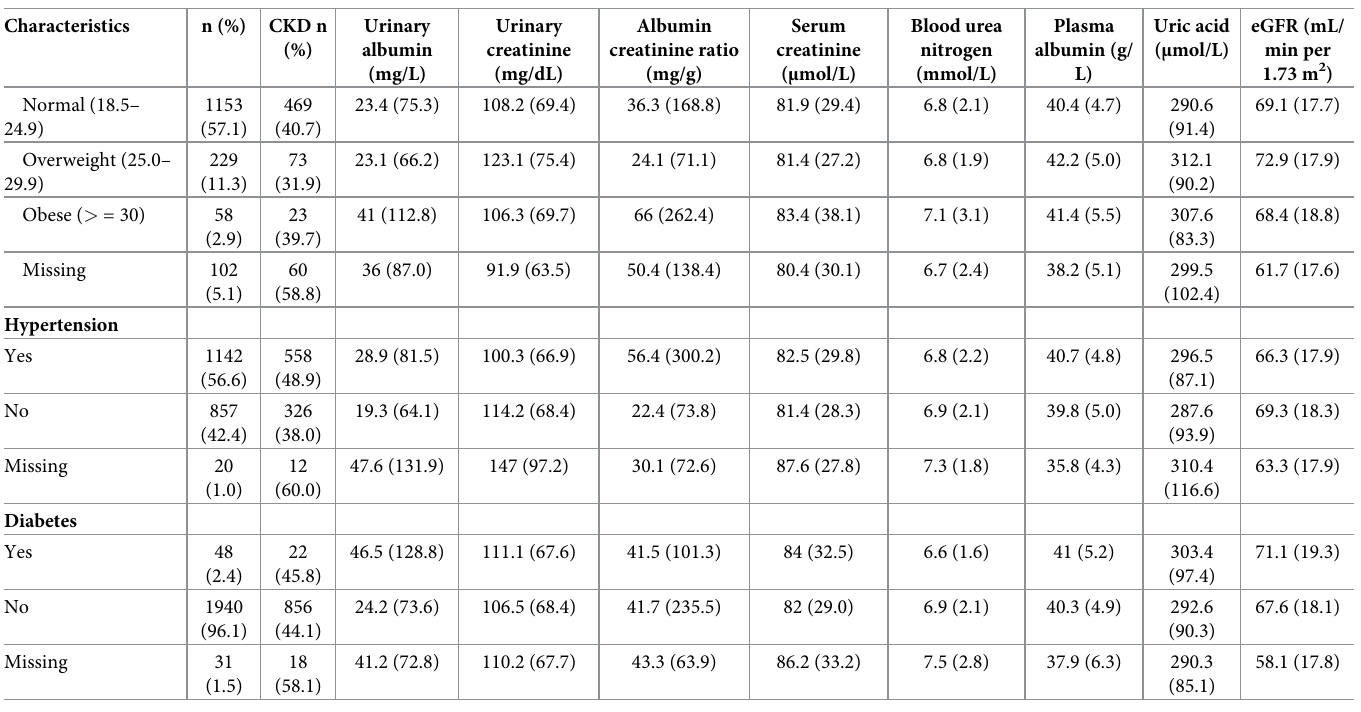
higher prevalence of CKD. Besides, Chinese participants who were female (54.2%) or under- weight (56.8%), or had the highest household income (50.3%), never smoked (47.8%), never drank (46.3%), did physical activity (46.3%), or had hypertension (48.9%) tended to have higher CKD prevalence. However, in the US, the prevalence was higher among people who were non-Hispanic White (44.9%), former smoker (44.2%), former drinker (48.1%), obese (44.9%), had income (PIR) < 1.87 (44.8%), did not do physical activity (45.6%), had hyperten- sion (49.7%) or self-reported diabetes (57.4%). Biomarkers’ level by the demographic characteristics The mean values of urinary albumin (mg/L), urinary creatinine (mg/dL), ACR (mg/g), serum creatinine ( μ mol/L), plasma albumin (g/L), uric acid ( μ mol/L) and eGFR (mL/min per 1.73 m 2 )